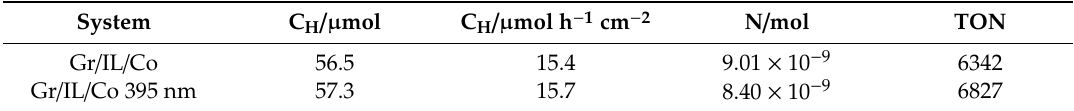
Table 3. Hydrogen concentration (C H ), amount of catalyst (N) and turnover number (TON) obtained using the systems Gr / IL / Co and Gr / IL / Co 395 nm.